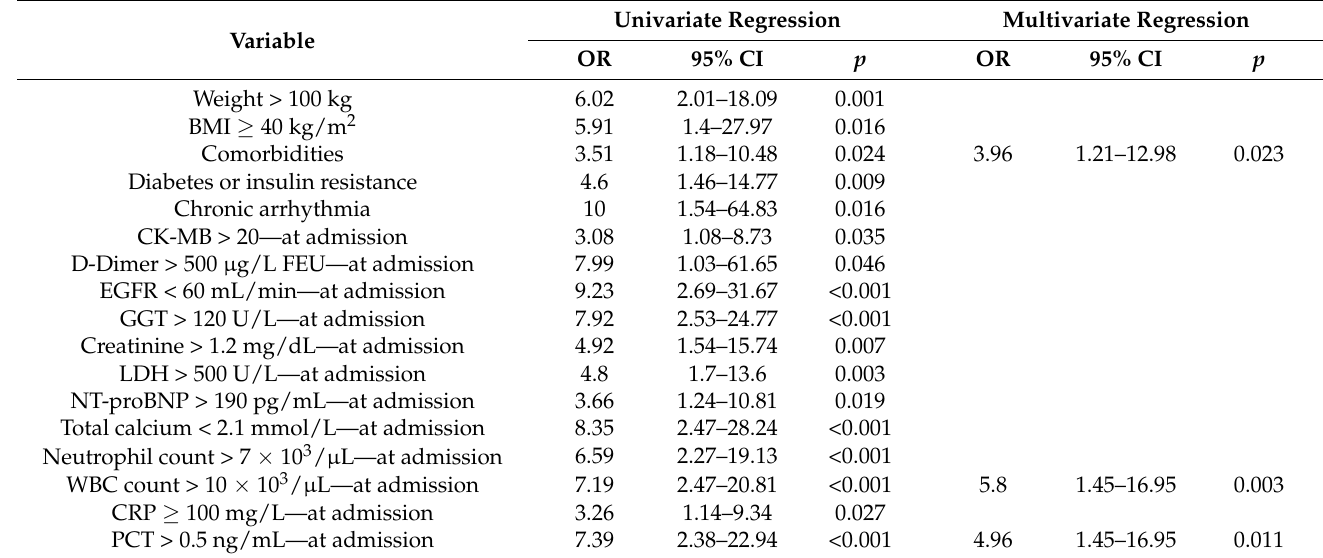
Table 8. Univariate and multivariate logistic regression analysis of selected clinical characteristics and laboratory parameters at admission for the prediction of